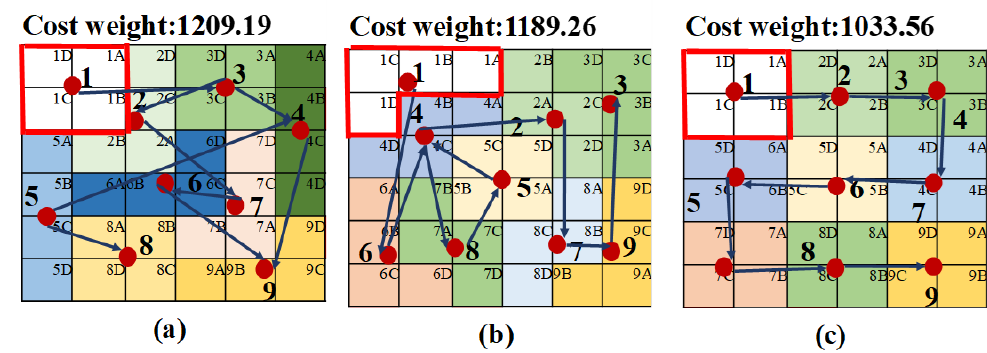
Figure 16. Optimal trajectories for the different tileset of the same 6 × 6 workspace. ( a ) optimal path consists of O, I, J, L, ( b ) Optimal path consist of L, S, J, O, Z, ( c ) Optimal path consist of only O.